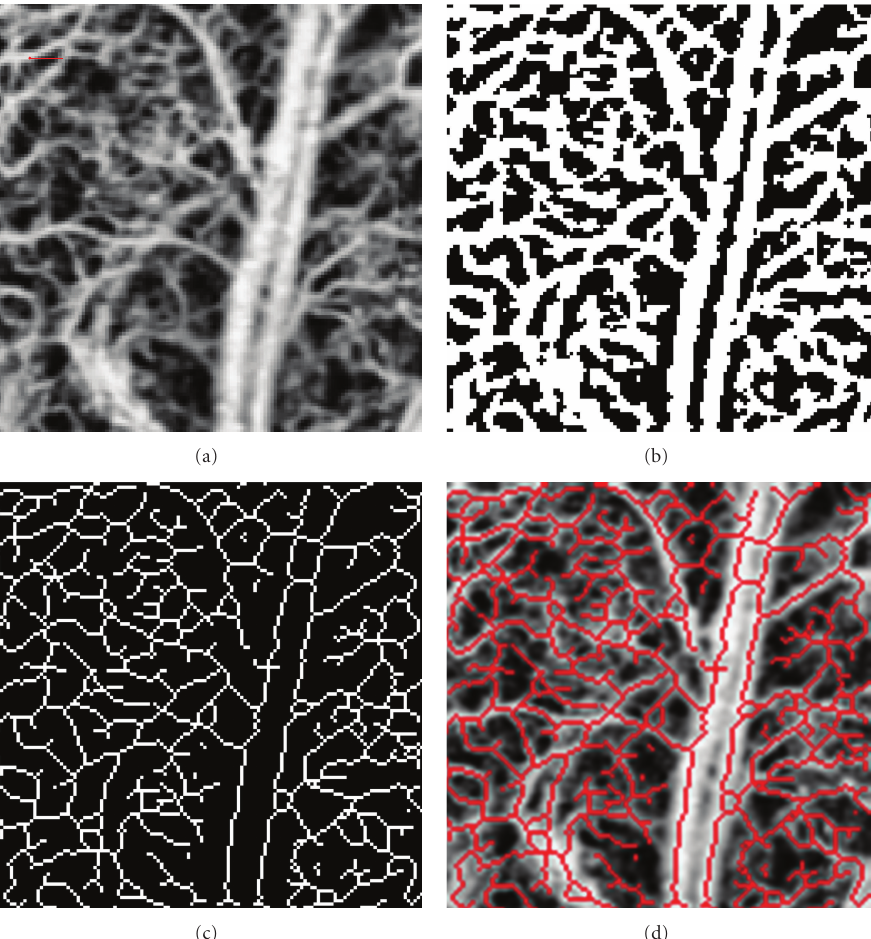
Figure 2: (a) OMAG image obtained from a mouse ear. Scale bar is 0.1 mm. (b) Black and white segmented image of (a). (c) Skeletonization of the segmented image (b). (d) Overlay of (c) and